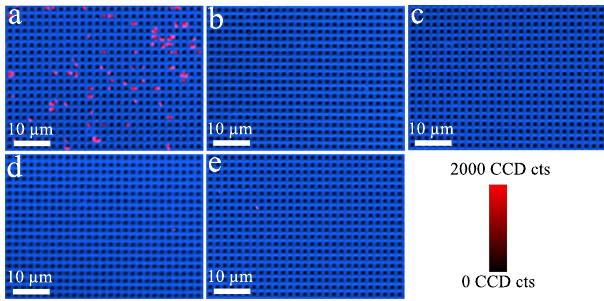
Fig. 4 Speci fi city of digital nanopillar SERS platform for FGF-2 cytokine detection. Representative confocal SERS images in the presence of a target FGF-2 (1031 aM), and negative controls with non-target controls b G-CSF (1031 aM), c GM-CSF (1031 aM), d CX3CL1 (1031 aM), and e PBS. The median (interquartile range) of active pillars per scanning image for FGF-2, G-CSF, GM-CSF, CX3CL1, and PBS was 72 (63.5 – 76.75), 1.5 (1.5 – 2), 2 (1 – 4), 0.5 (0 – 1.25), and 1 (1 – 1.75), respectively. Data from one independent